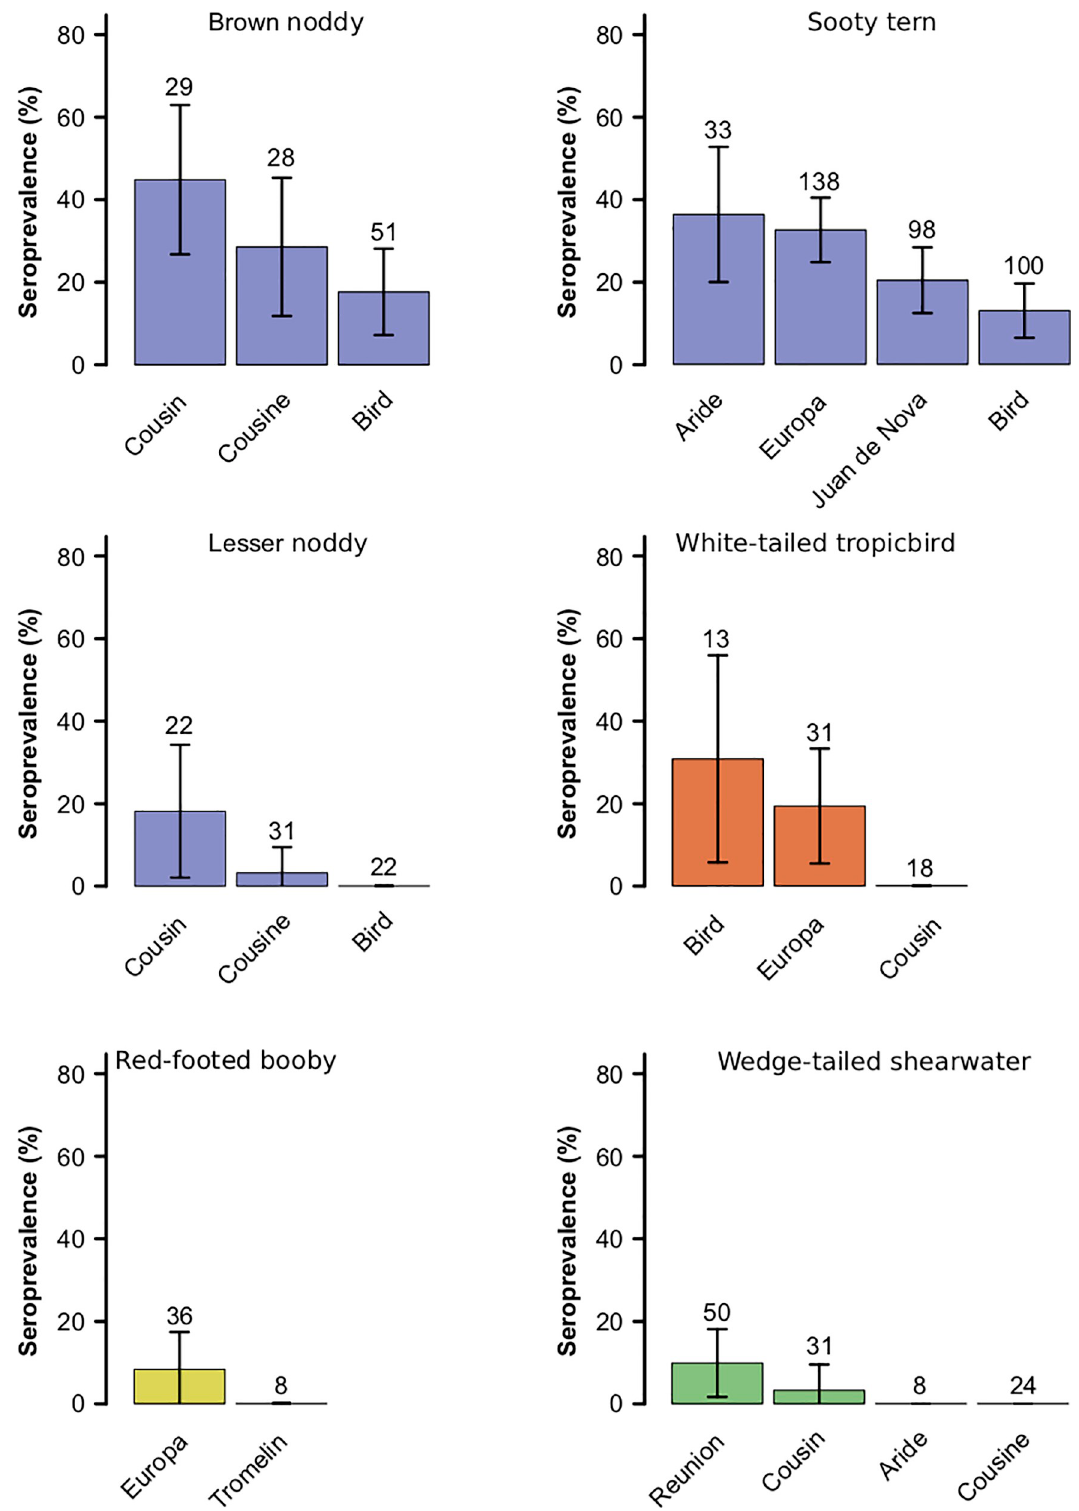
Fig 4. Seroprevalence of antibodies to Toxoplasma gondii per species and island in the adult seabirds sampled in the Western Indian Ocean (sample size and percentage with 95% confidence intervals). Sample sizes are indicated above bars. Colours indicate bird orders (blue: Charadriiformes, red: Phaethontiformes, yellow: Suliformes, green: Procellariformes). Juan de Nova and